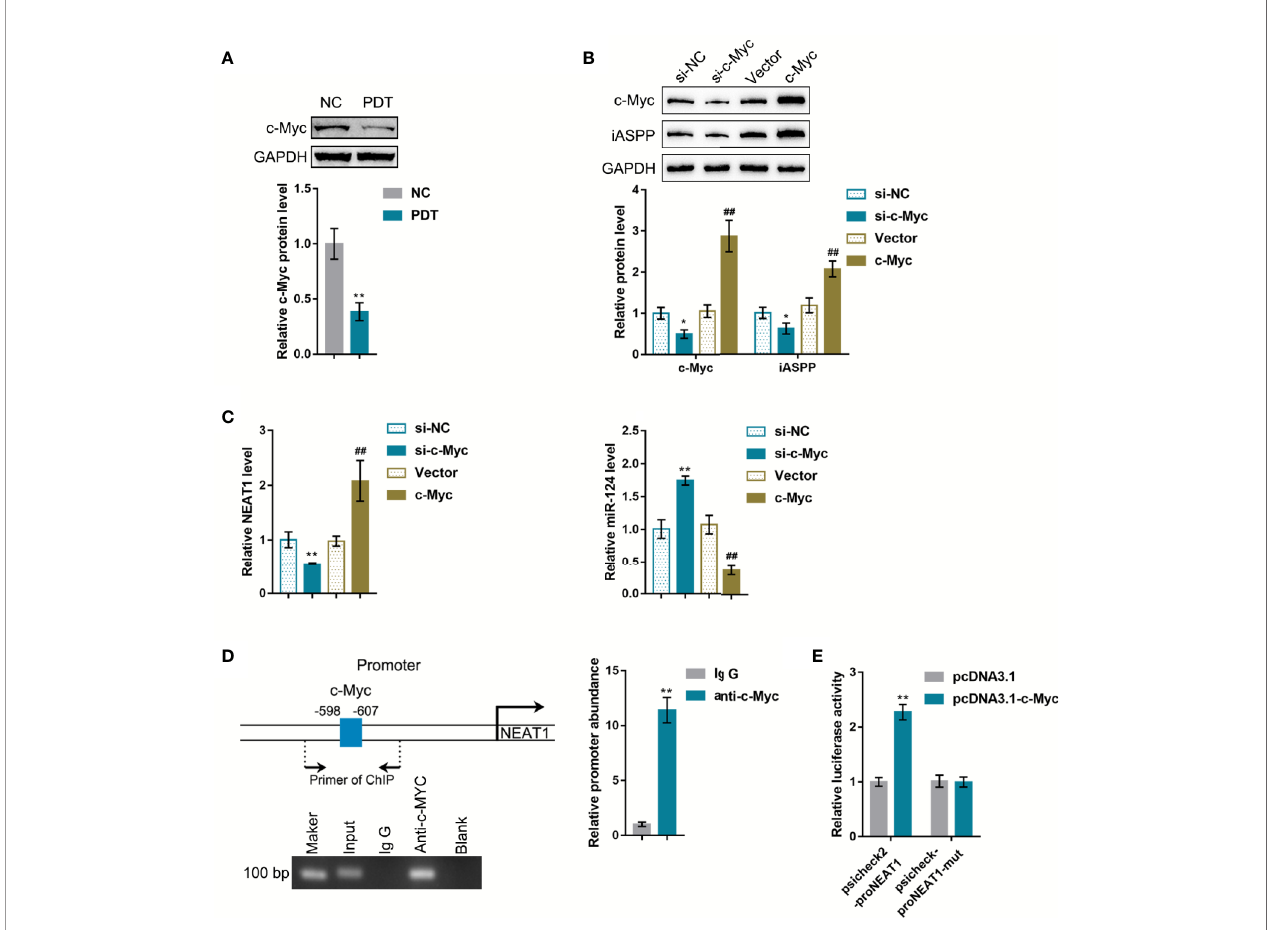
FIGURE 5 | c-Myc binds to the promoter region of NEAT1 to activate the transcription. (A) HCT116 cells were treated or non-treated with PDT and examined for the protein levels of FoxO3, Nrf2, and c-Myc by Immunoblotting. (B) c-Myc overexpression or silencing was achieved in HCT116 cells by transfecting si-c-Myc or c-Myc-overexpressing vector. The protein levels of c-Myc and iASPP in transfected cells were determined by Immunoblotting. (C) HCT116 cells were transfected with si-c-Myc or c-Myc and examined for the expression levels of NEAT1 and miR-124 by qRT-PCR. (D) ChIP assay was performed using anti-c-Myc or anti-IgG. The levels of NEAT1 promoter in the immunoprecipitate were determined by qRT-PCR. (E) NEAT1 promoter reporter vectors, psiCheck2-proNEAT1 and psiCheck2- proNEAT1-mut, were constructed and co-transfected in 293T cells with pcDNA3.1/c-Myc. The luciferase activity was determined. * P < 0.05, ** P < 0.01, ## P <